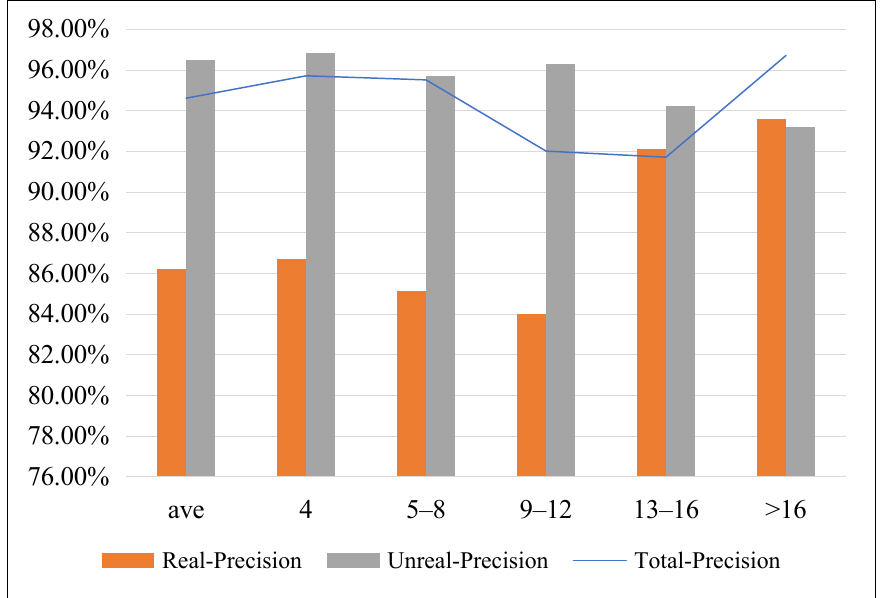
Figure 12. The performance of